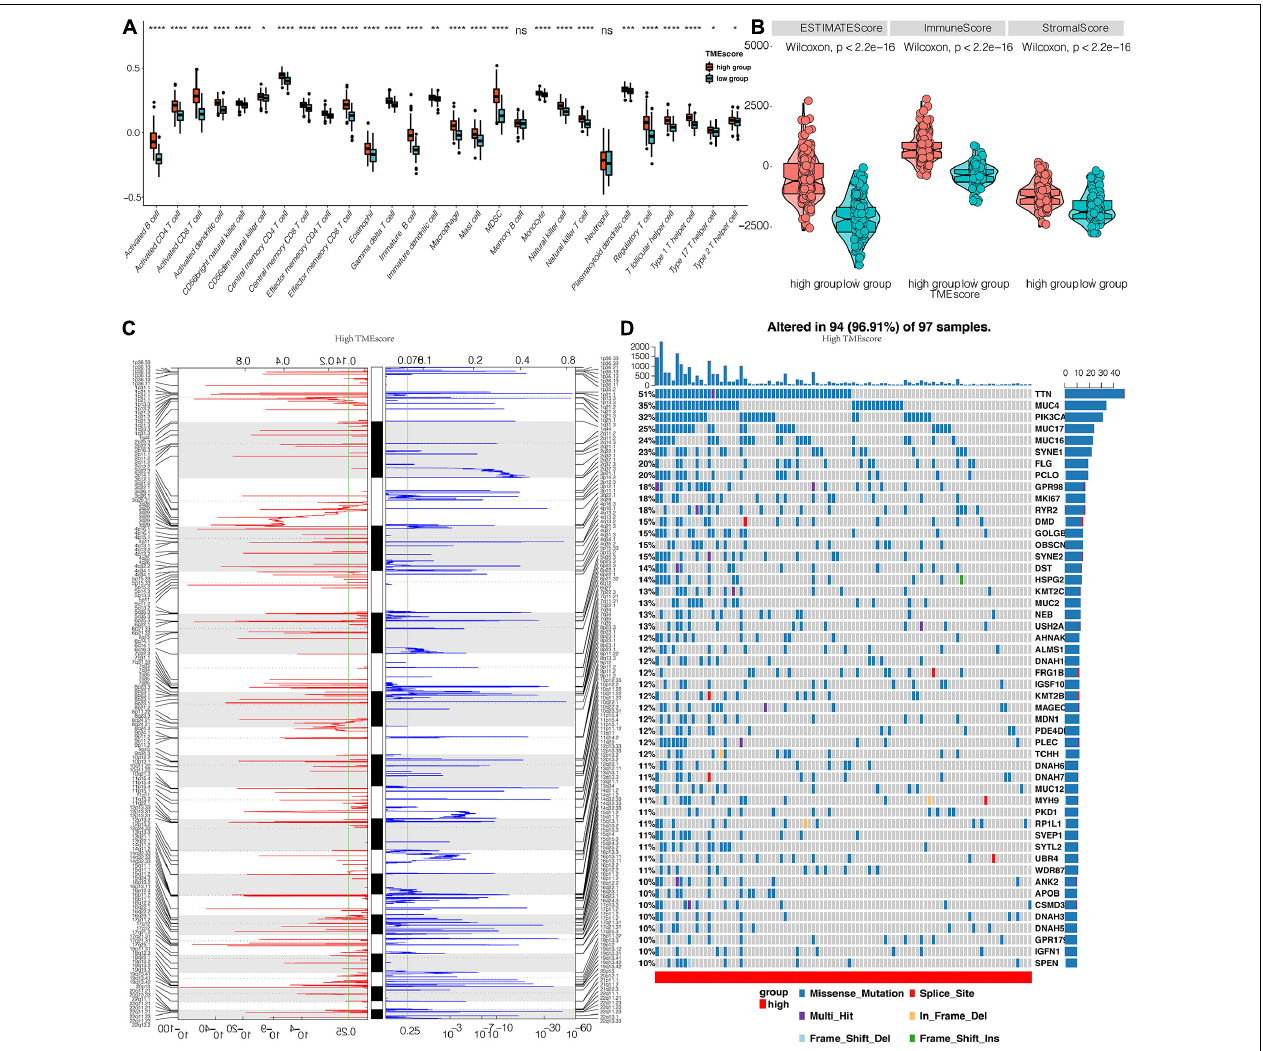
FIGURE 6 | Genomic profiles associated with the TME score. (A) The distribution of immune cells in TME score clusters for TCGA. (B) The differential expression of Estimate, Immune, and Stromal Score for TME score in the TCGA dataset. (C) GISTIC 2.0 amplifications and deletions in CESC with high TME score. Chromosomal locations of peaks of significantly recurring focal amplification (red) and deletions (blue). (D) Differential somatic mutations in CESC with a high TME score. *, P < 0.05; **, P < 0.01; ***, P < 0.001; ****, P < 0.0001; ns, not statistically